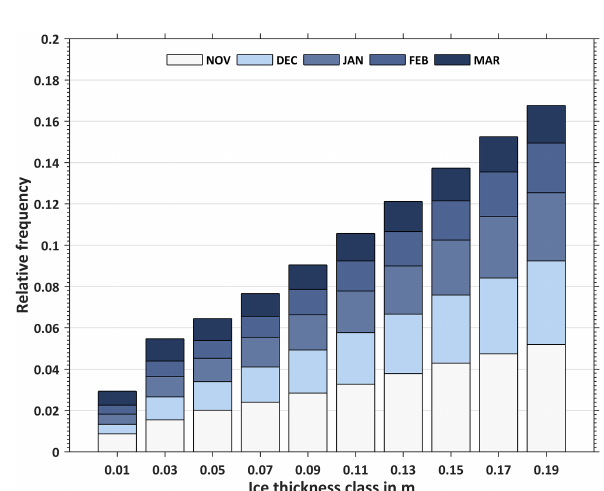
Figure 3. Thin-ice thickness distribution ( ≤ 20cm) in the Laptev Sea derived from MODIS data for the winter periods (November– March) 2002/2003–2014/2015. The bars indicate the relative distri- bution of each thickness class from the total number of TIT ≤ 0.2m appearances between the winter seasons 2002/2003 and 2014/2015. Contributions of each month with respect to the whole winter sea- son for each thickness class are indicated by the blueish colours (see the legend). The mean thickness ( ± 1 standard deviation) in this period is 13.5 ± 0.5cm (8.7cm for ≤ 10cm). In the winter pe- riod 2007/2008, the mean is 14.0 ± 2cm (7.7cm for ≤